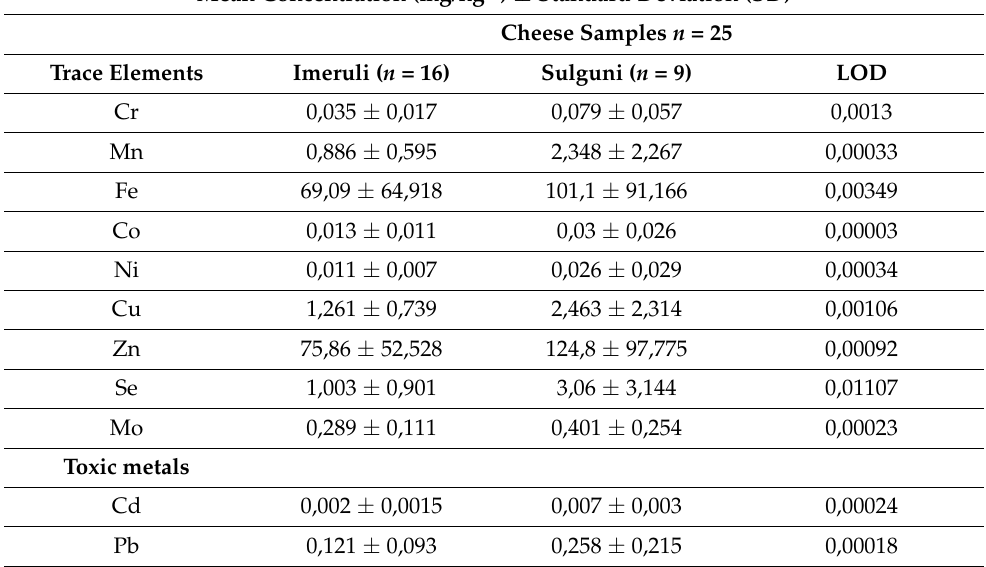
Table 2. Trace elements and toxic metals in Imeruli and Sulguni cheese n = 25 (mean ± standard deviation; mg/kg ww) were obtained in an area with water and pastures contaminated with heavy metal (caused by mining industry) in the Kvemo Kartli region, Georgia. Mean Concentration (mg/kg *) ± Standard Deviation (SD) Cheese Samples n =